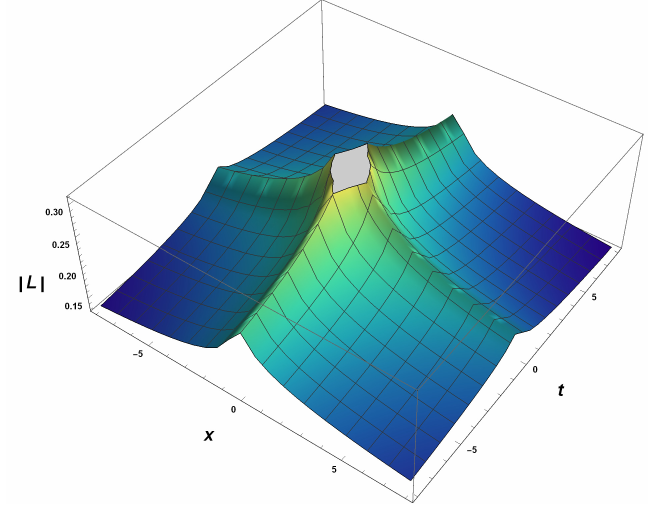
Figure 8. The 3D graphical representation of solitary-wave solutions, i.e., | L 31 | across β = 0.3. Figure 9: A contour plot is a computational technique for viewing the 3D plane on a 2D structure via representing constant “ | L | ” sheets, also known as contours. A 2 D representation of a 3 D surface plot is a contour plot. Contour plots are available in several general-purpose mathematical research kits. So they work on a wide range of overall visualization and math programs as well.